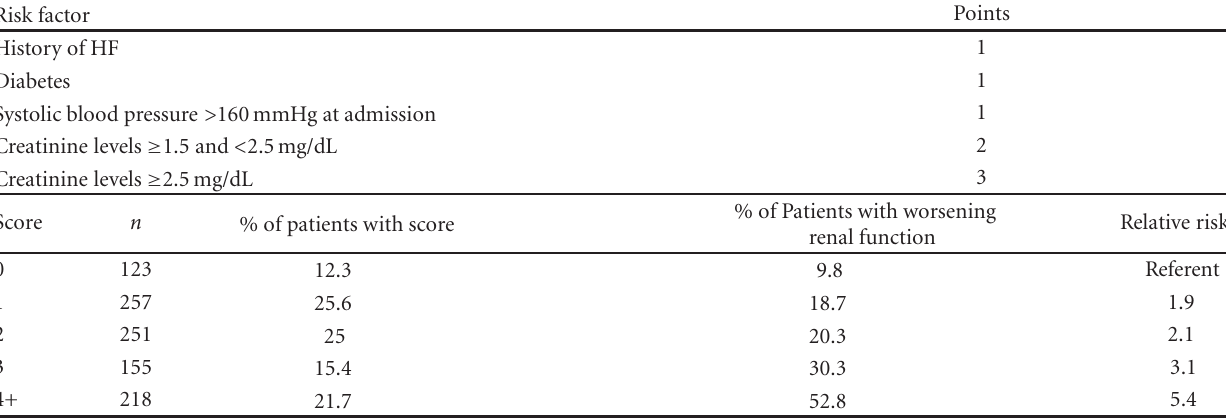
Table 2: Risk score developed by Forman et al. to predict worsening renal function